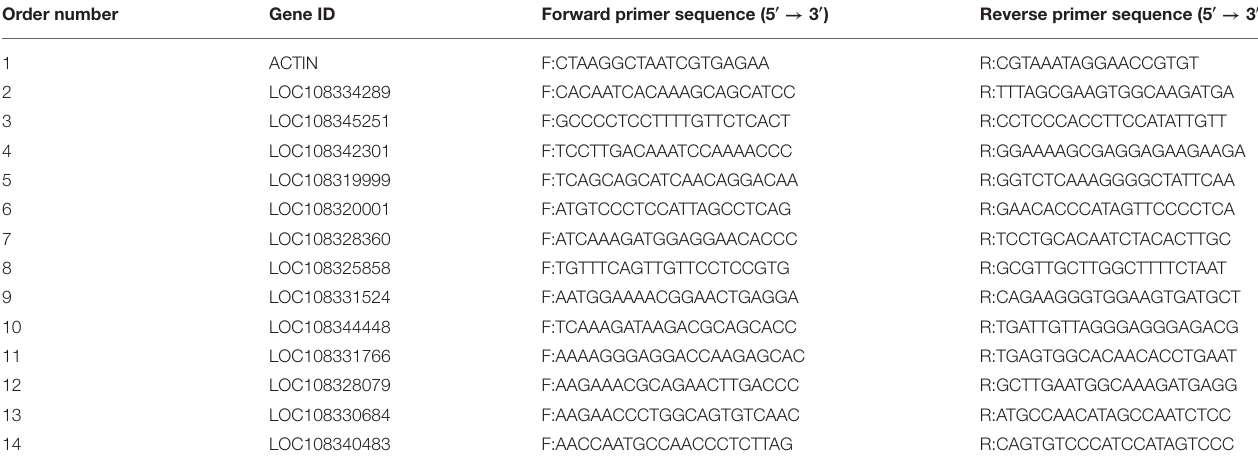
TABLE 2 | Primers for qRT-PCR.